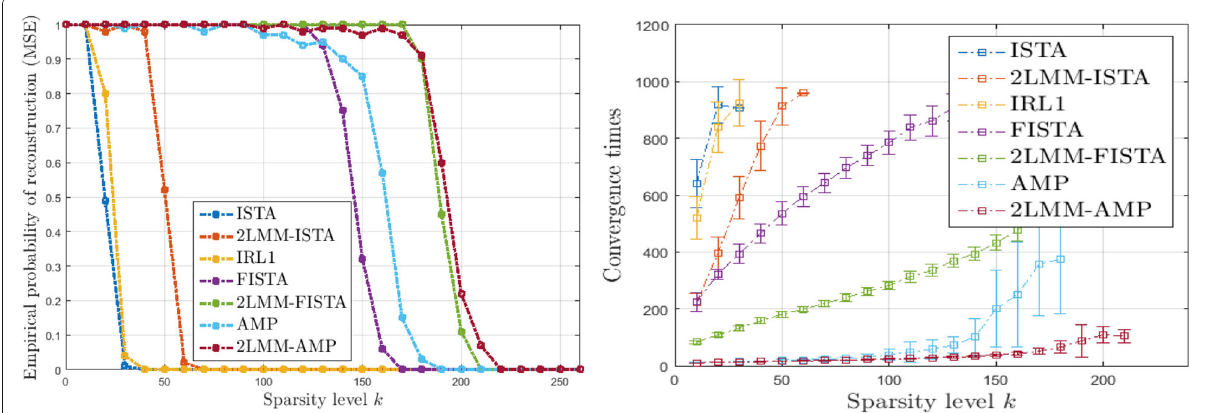
Fig. 9 Analysis of performance for 5P1 signals: empirical probability of successful recovery as a function of the sparsity value k with n = 512 and m = 350 for sparse Bernoulli-Binomial signals